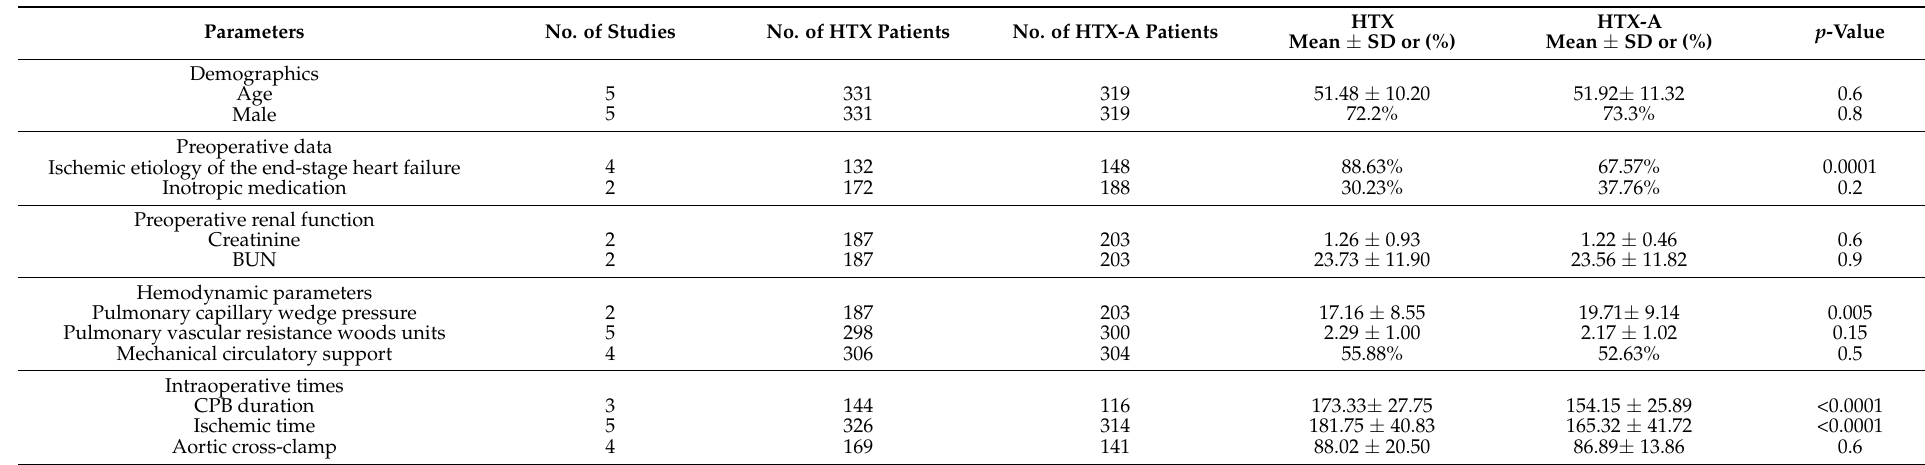
Table 2. Baseline characteristics and periprocedural